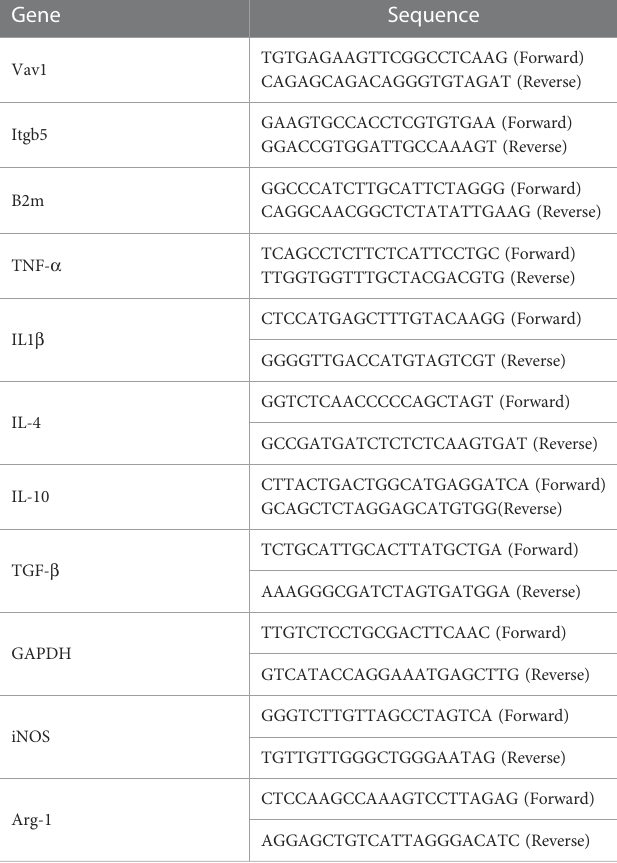
TABLE 1 The primers for Real-Time Quantitative